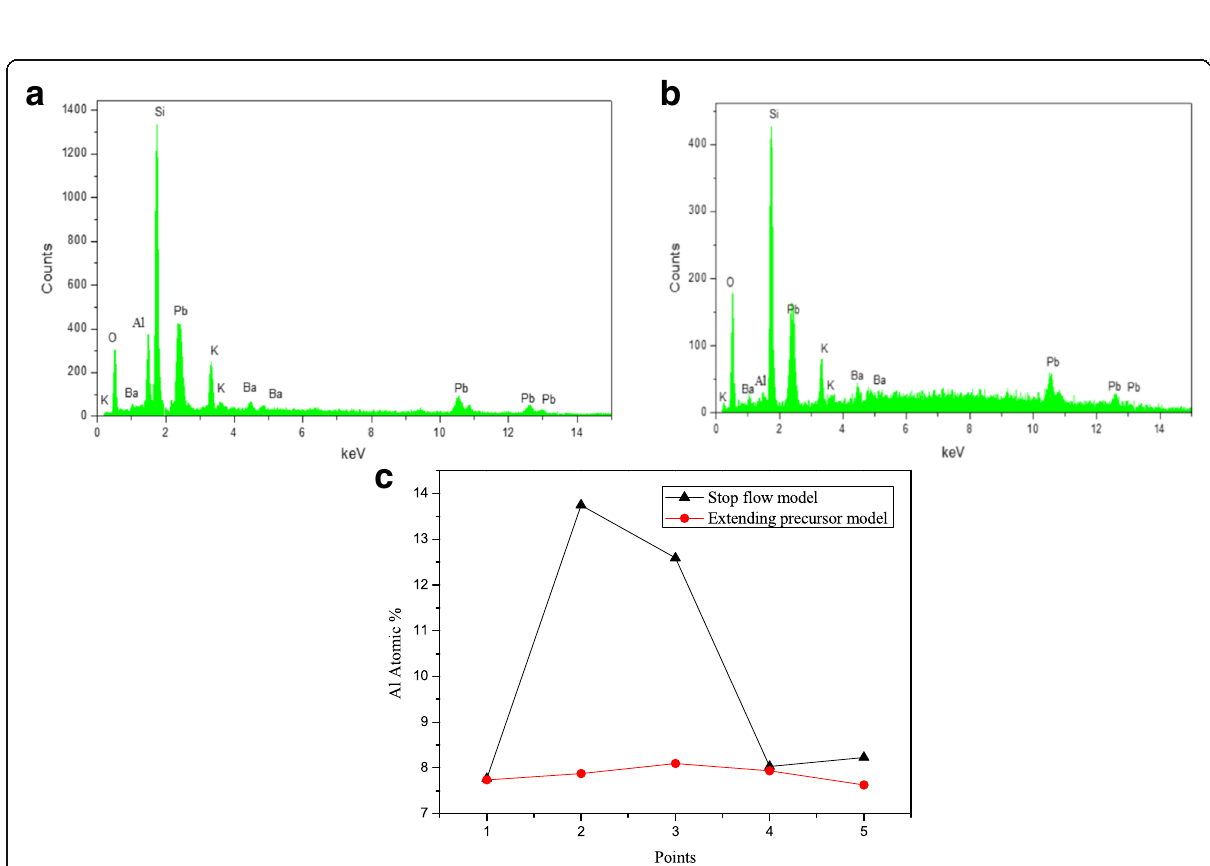
Fig. 5 Spectra and elemental composition of cross-sectional MCP samples. a Spectra and elemental composition of ALD MCP. b Spectra and elemental composition of uncoated MCP. c Al distribution of samples deposited by stop flow model and extending precursor